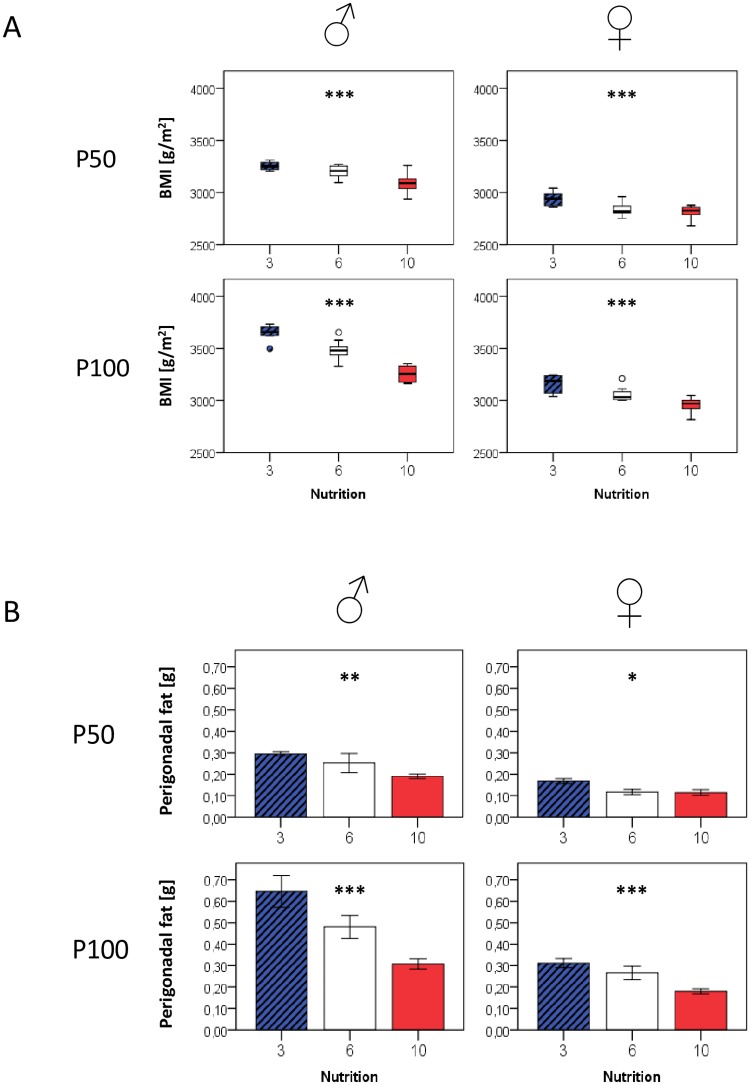
BMI (Fig. 2A) and perigonadal fat mass (Fig. 2B) at P50 and P100 in relation to postnatal nutrition and gender.Group differences for both parameters tended to further increase with age. If not indicated otherwise, displayed significance levels (* p<0.05, ** p<0.01, *** p<0.001) refer to comparisons between all three nutrition groups (ANOVA). P50: n = 4–10 animals per nutrition group and gender; P100: n = 5–10 animals per nutrition group and gender.